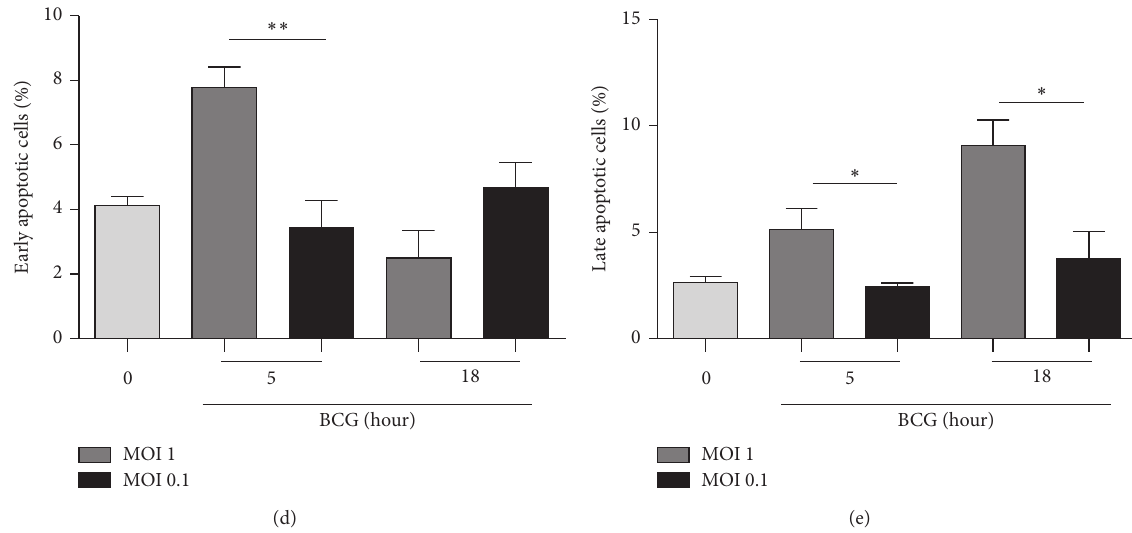
Figure 1: BCG infection at MOI 1 but not MOI 0.1 induces cell death. (a) Uninfected RAW macrophages were cultured or, (b) and (c), infected with BCG Pasteur at MOI 1 and MOI 0.1 during 2, 5, and 18 hours and stained with Annexin-V and 7-AAD to assess the percentage of cell death by flow cytometry as shown in the representative plots. (b) Representative FCS and SSC scatter plots of cells infected for 5 h with MOI 1 and (c) Annexin-V versus 7-AAD at 5 and 18h. Percentage of early (d) and late (e) apoptosis induced by BCG at 5 and 18 h. Two-tailed unpaired Student’s 𝑡 -test was used to compare percentage of infected cells MOI 1 versus MOI 0.1. Bars indicate mean ± SEM from four independent experiments. ∗∗ 𝑃 < 0.01 ; ∗ 𝑃 < 0.05 . Light grey refers to uninfected